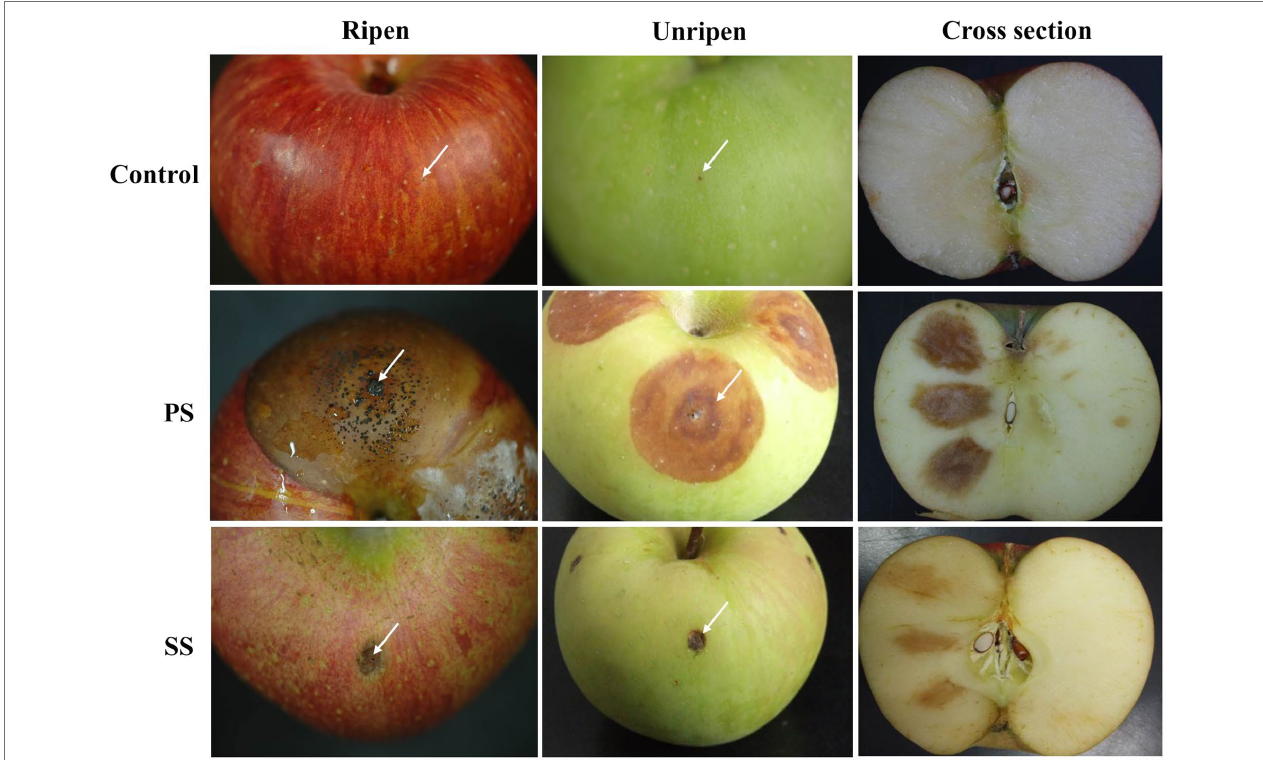
FIGURE 4 | Virulence test of PS and SS on ripe and unripe apple fruits (cv. Fuji). Progressive symptoms (PS) of anthracnose appear as sunken lesions on ripe apples, with concentric circles of conidia. Static symptoms (SS) of anthracnose were not enlarged on ripe fruits after 7 days of incubation at 25 ° C. Each treatment contains five replicates (fruits), and the experiment was performed